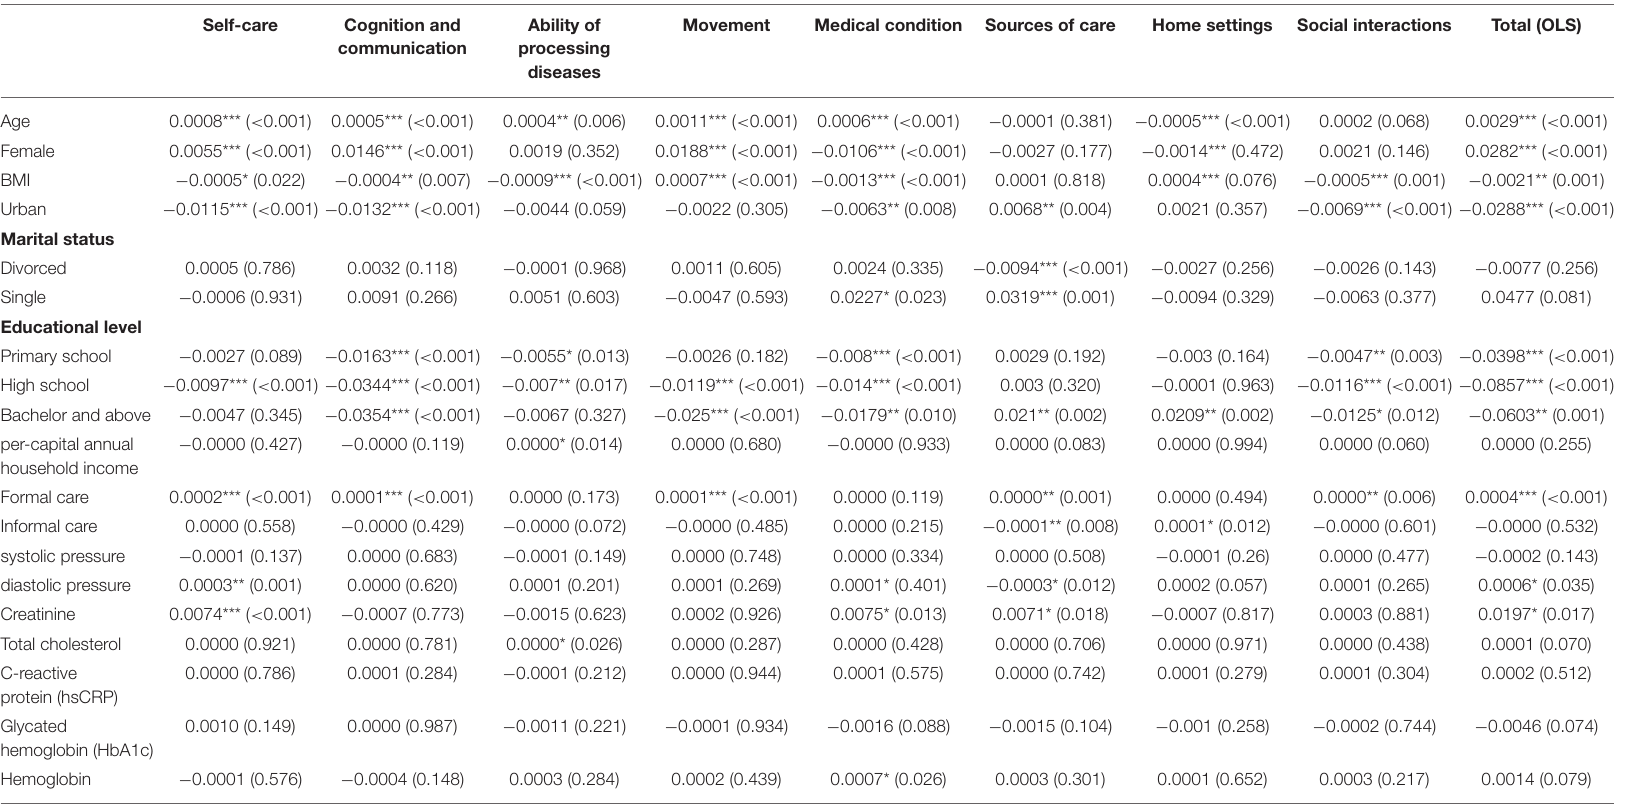
TABLE 11 | Analysis of influencing factors of multidimensional